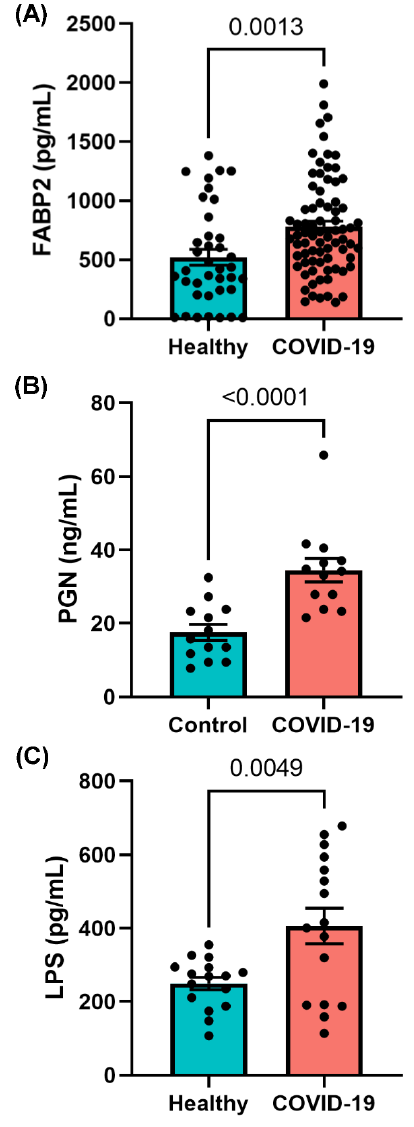
Figure 4. SARS-CoV-2 infection induces increased gut permeability and endotoxemia. ELISA results of plasma ( A ) fatty acid binding protein 2 (FABP2) and the gut microbial antigens ( B ) peptidoglycan (PGN) and ( C ) lipopolysaccharide (LPS) which indicate increased gut barrier integrity and increased endotoxemia in COVID-19-infected subjects. Data are presented as mean ± S.E.M. Each dot represents a sample in the cohorts. Student’s t-test p -values are indicated where applicable.